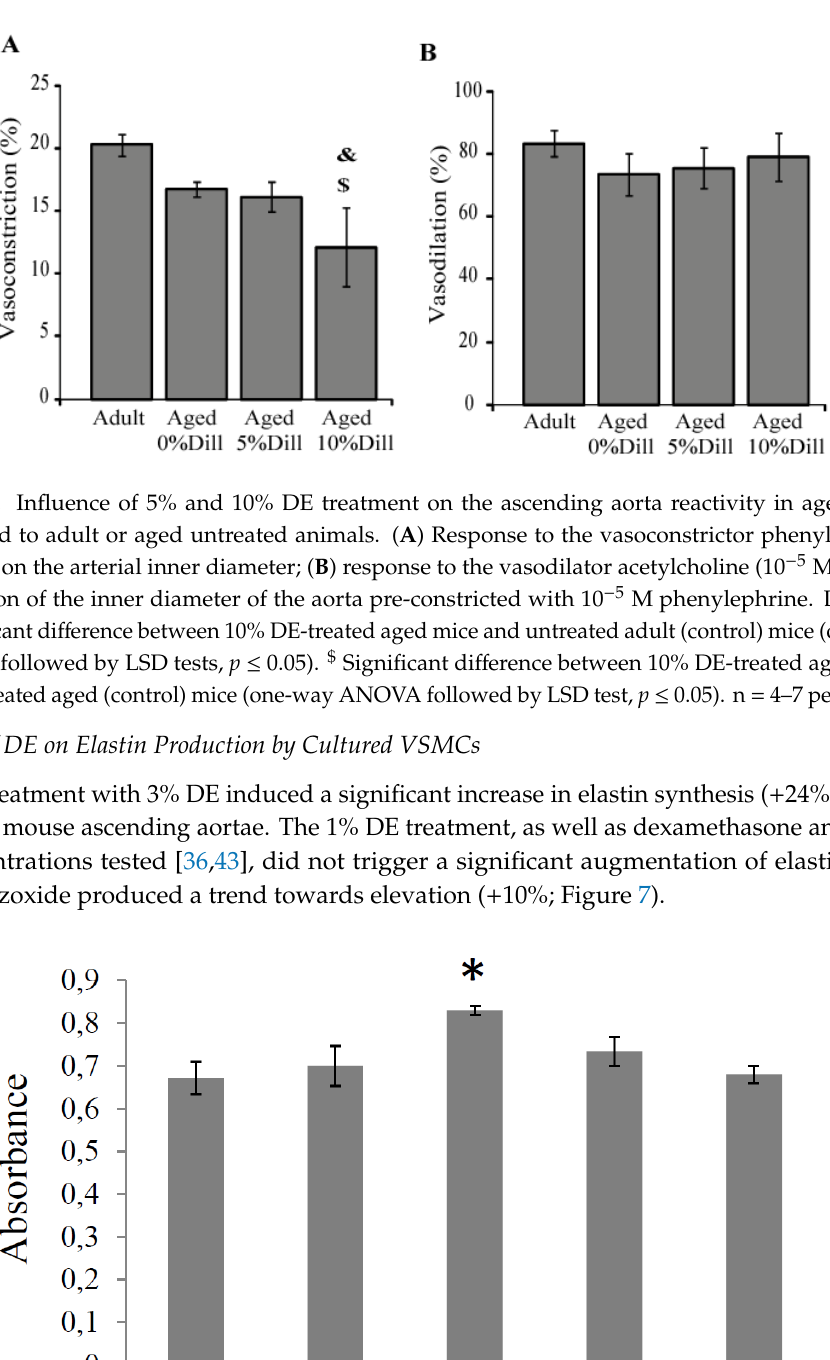
11 of 19 Figure 5 . Mechanical parameters of the ascending aorta of untreated 5% DE- or 10% DE-treated aged mice, as well as untreated (control) adult animals. ( A ) Aortic distensibility-pressure increment relation; ( B ) circumferential stress-pressure relation; ( C ) stress-strain relation; ( D ) incremental elastic modulus (Einc)- pressure increment relation. * Significant difference between untreated adult and untreated aged mice (two-way ANOVA followed by LSD test if necessary, p ≤ 0.05). & Significant difference between 10% DE-treated aged mice and untreated adult mice (two-way ANOVA followed by LSD test if necessary, p ≤ 0.05). $ Significant difference between 10% DE-treated aged mice and untreated aged mice (two-way ANOVA followed by LSD test if